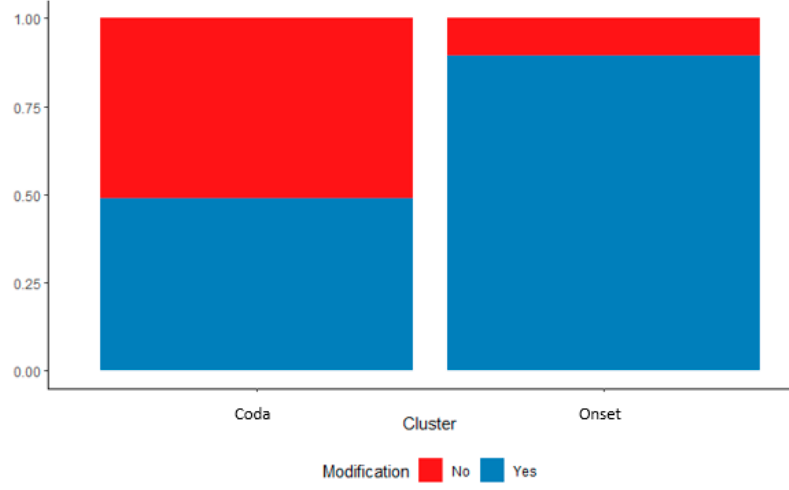
Figure 5. Percentage of onset and coda consonant clusters modification.